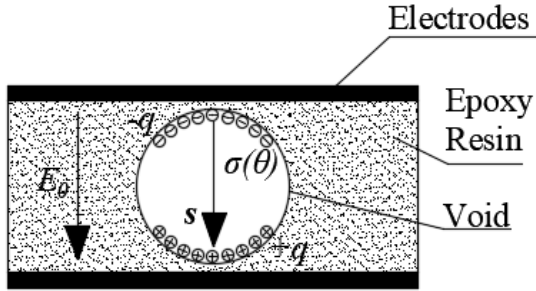
Figure 1. Dipole moment due to charge on cavity surface. E 0 is the electric field strength outside the void due to applied electrodes and s is the unit dipole vector.